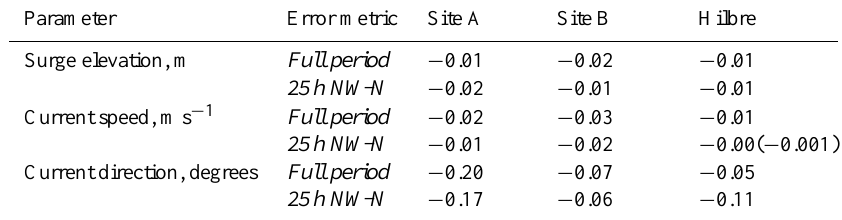
Table 1. The mean values of the time-varying differential accuracy metric ( DA , plotted in Figs. 3–5) for the full study period and a 25h period of NW-W winds (starting at 19:00GMT, 2 March 2008). Negative values indicate the Charnock relation is performing with higher accuracy at this site than the COARE bulk wind stress formula and vice versa for positive values. For zero values an extra degree of precision has been included in the bracketed value.